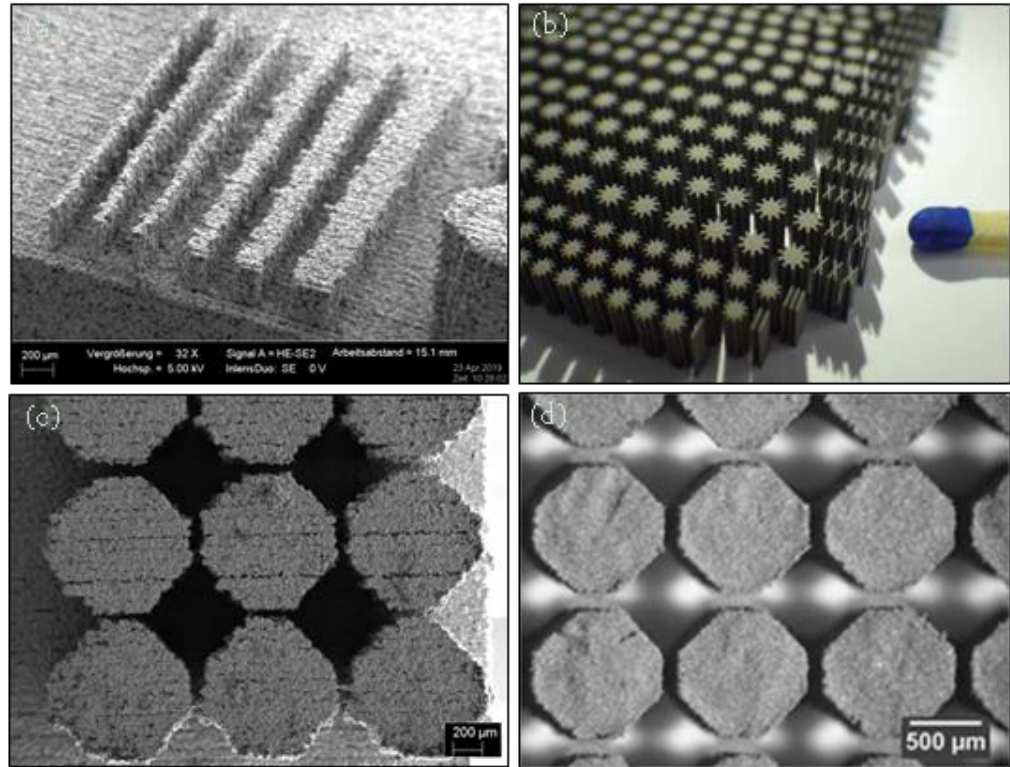
Figure 20. ( a ) Thin walls 316L printed using BJ technology, ( b ) serial production of micro-parts aspect ratio of 1:50 printed using 3DSP [155], ( c ) a benchmarking sample part printed using BJ technology, ( d ) the benchmark sample printed using 3DSP [162].